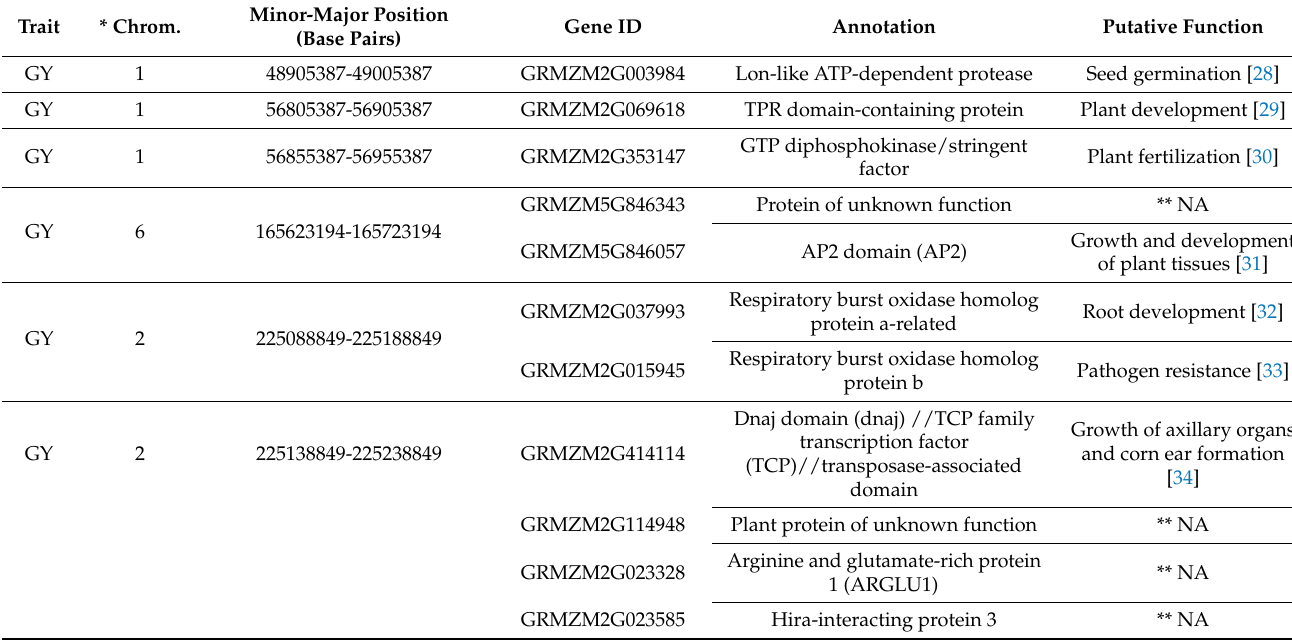
Table 1. Candidate genes detected by regional heritability analysis for four traits of interest for popcorn in environment